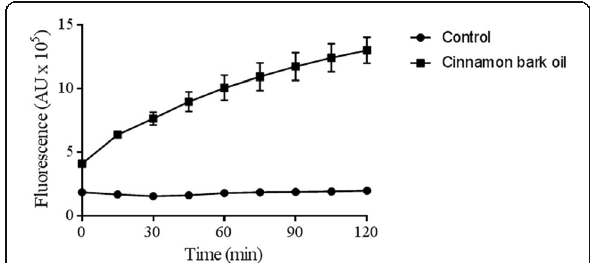
Fig. 1 Effect of cinnamon bark oil on the membrane integrity of C. albicans ATCC 28266 as determined using SYTOX® Green dye, which penetrates damaged cytoplasmic membranes. C. albicans cells were incubated with cinnamon oil at its MFC and fluorescence was recorded for 2 h